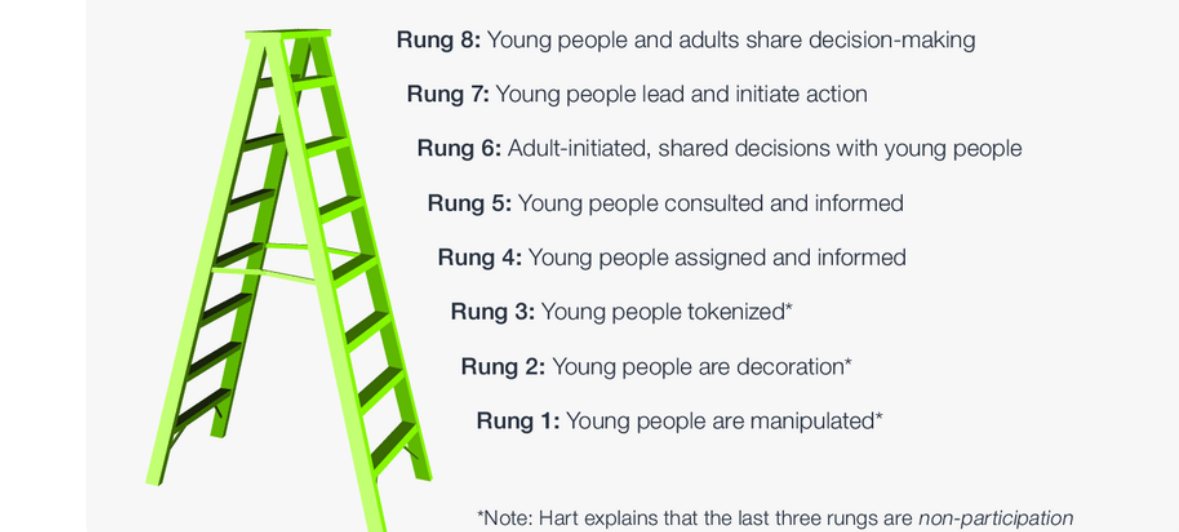
Figure 1: Roger Hart’s ladder of young people’s